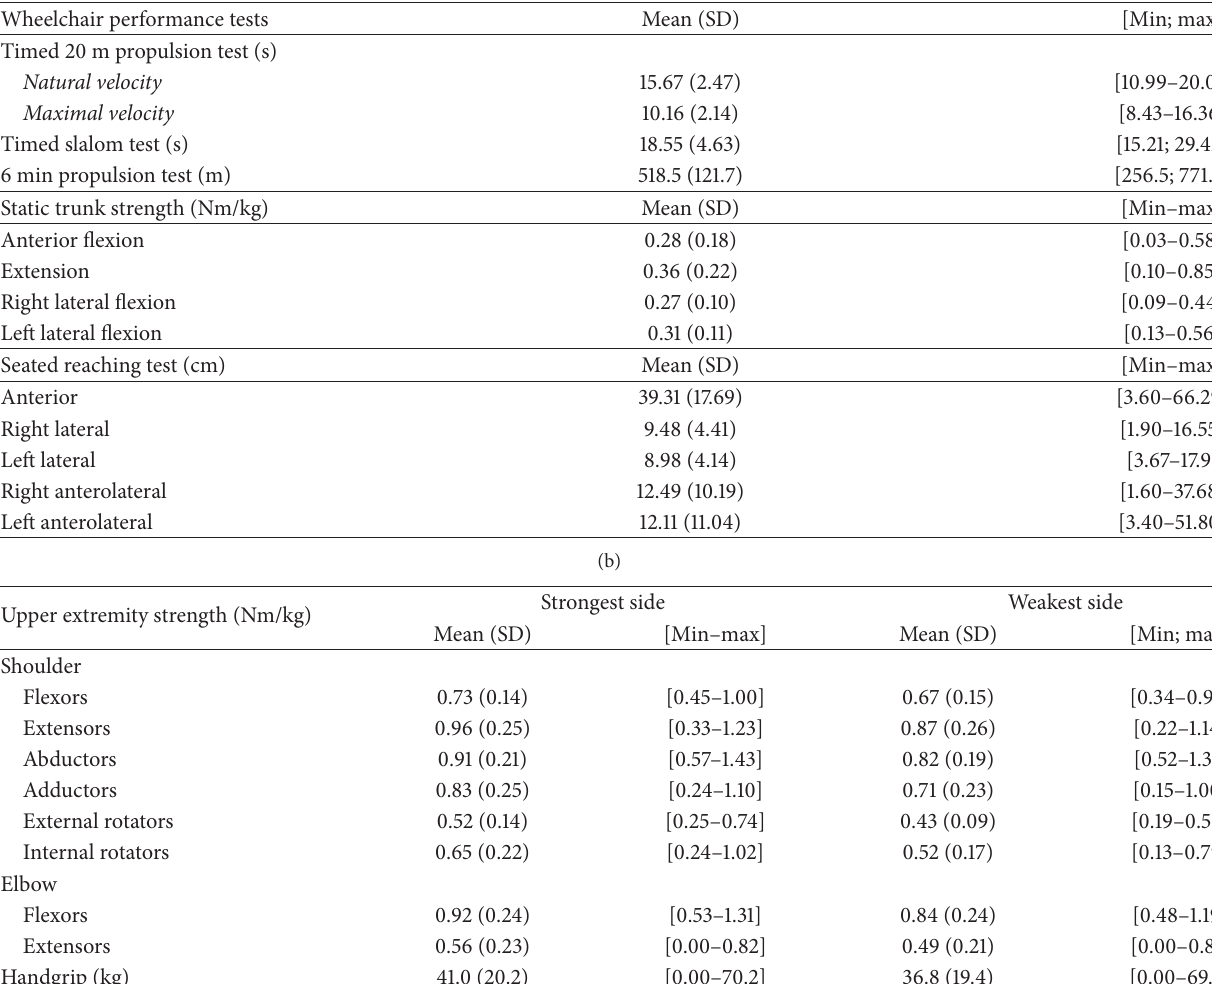
Table 2: Summary of outcome